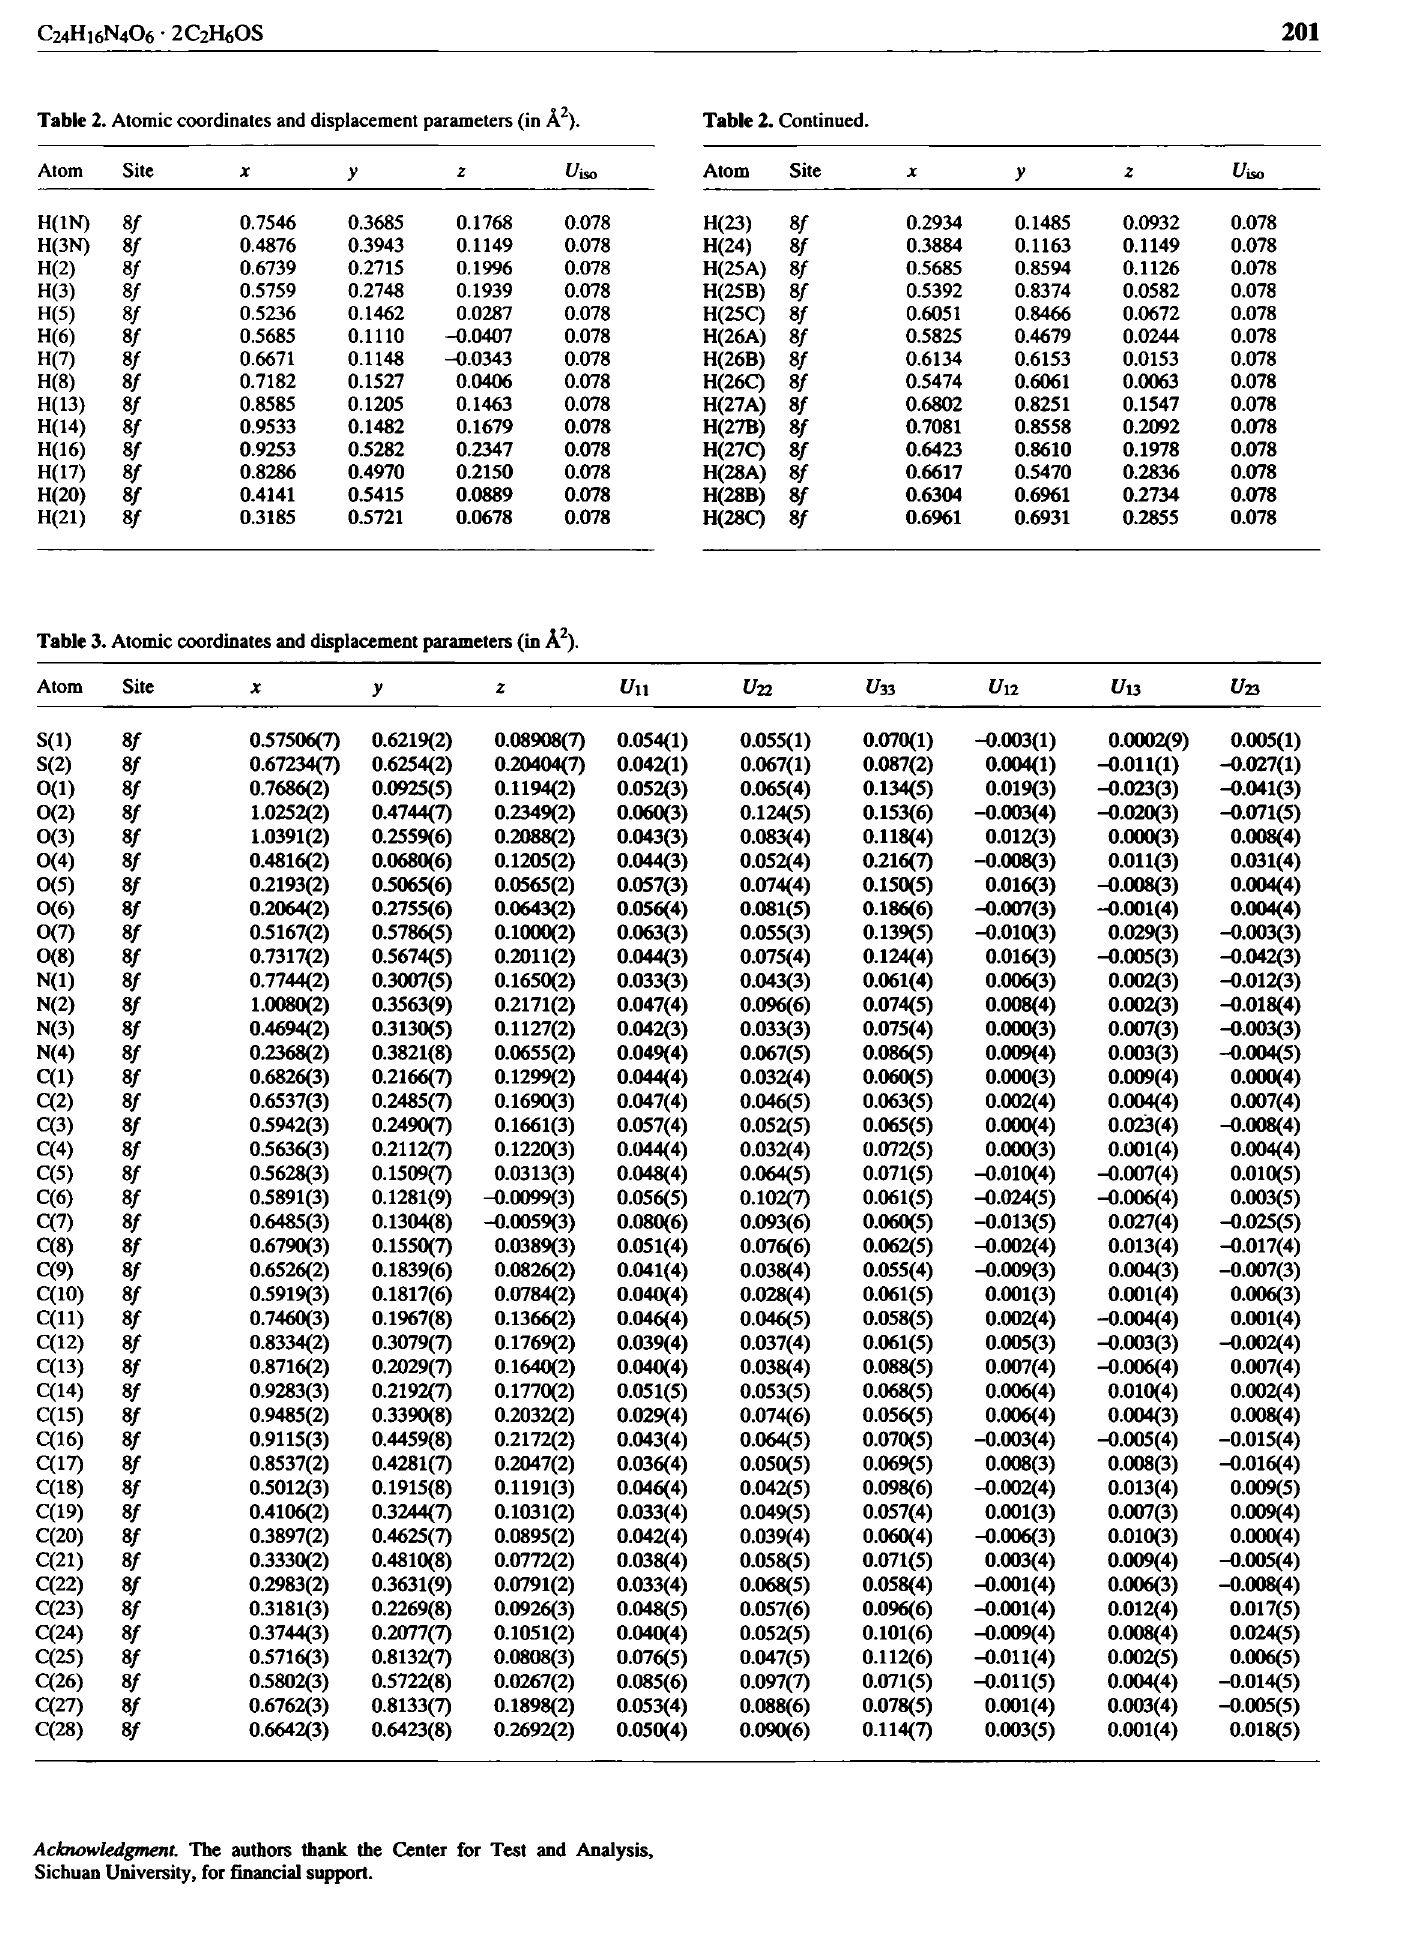
Table 2. Atomic coordinates and displacement parameters (in Ä 2 ).